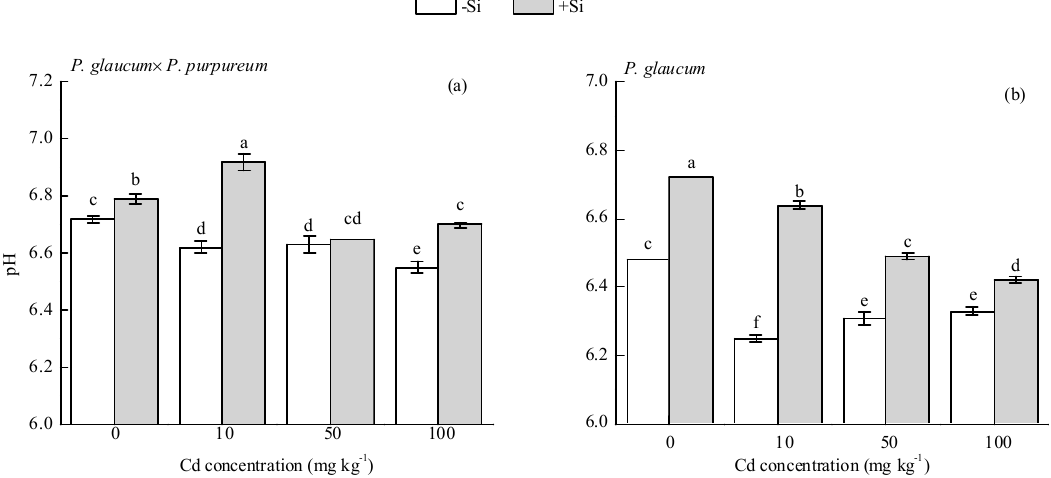
Figure 2. E ff ect of Si on soil pH of ( a ) P. glaucum × P. purpureum and ( b ) P. glaucum . Values are mean ± SE ( n = 3). Values followed by the di ff erent letters indicate significant di ff erences between di ff erent treatments of the same variety, according to one-way ANOVA and Duncan test ( p <